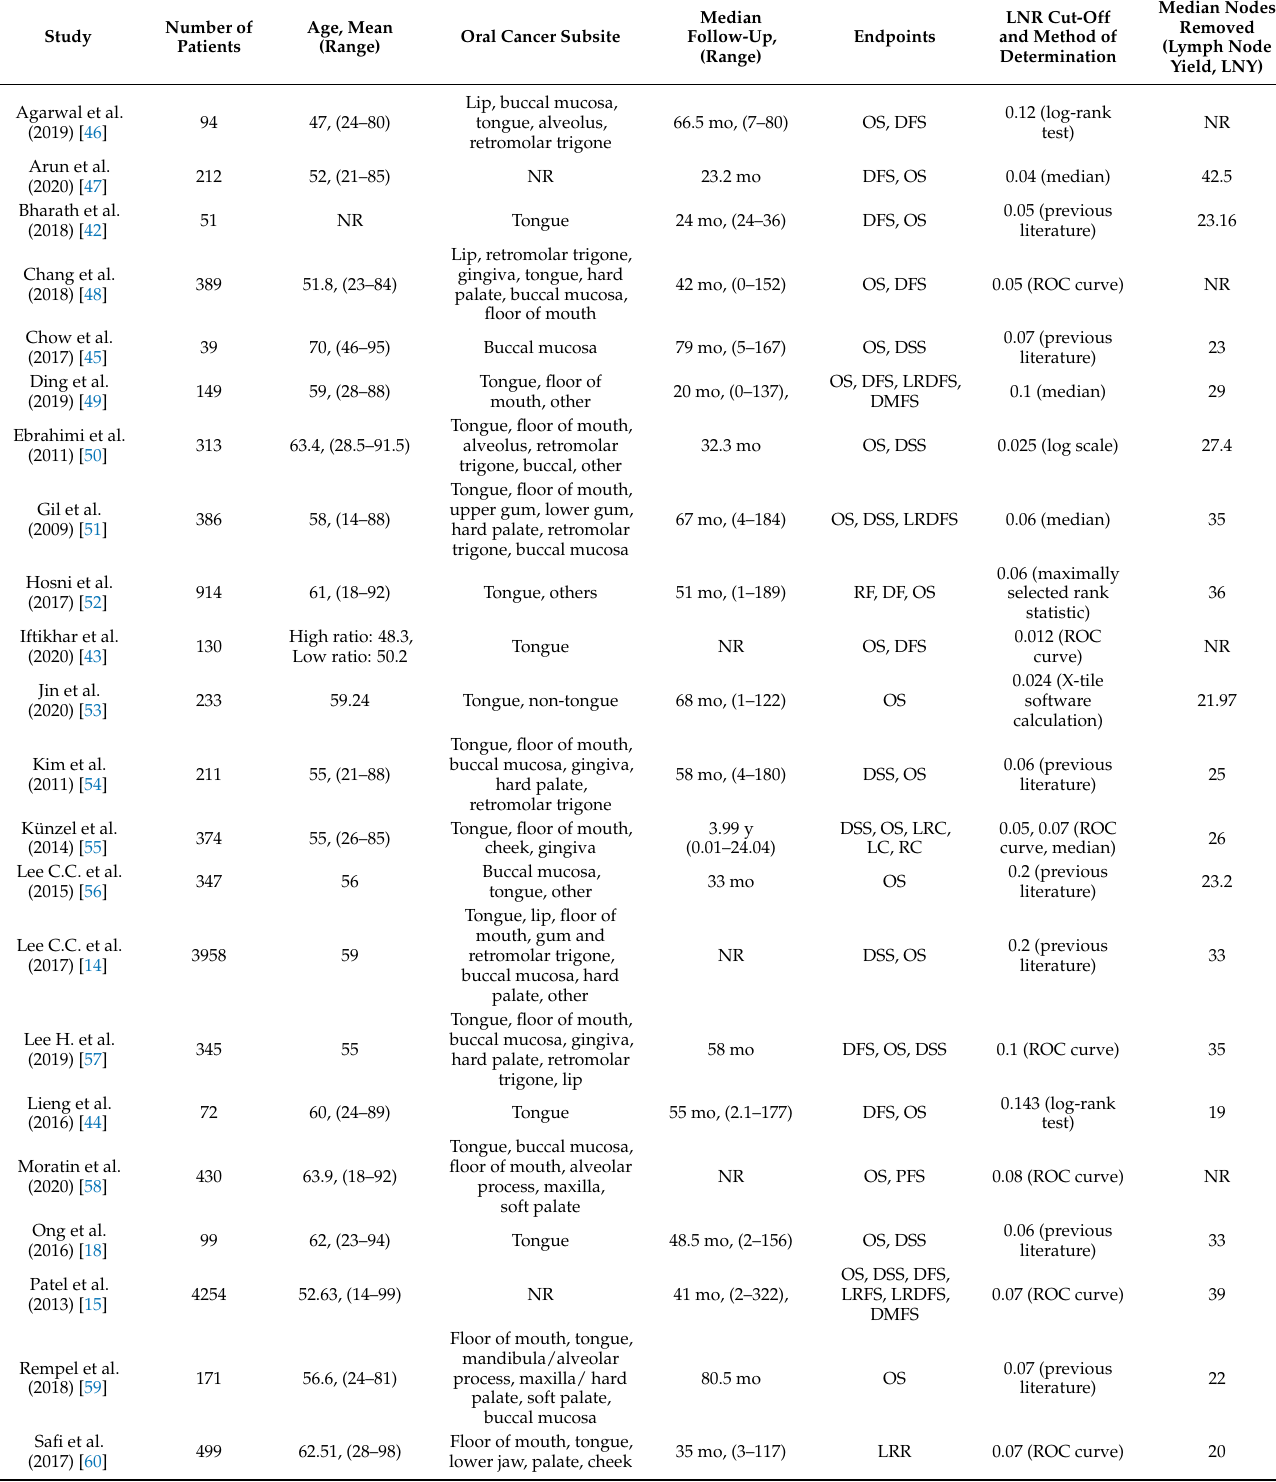
Table 1. Main characteristics of the eligible